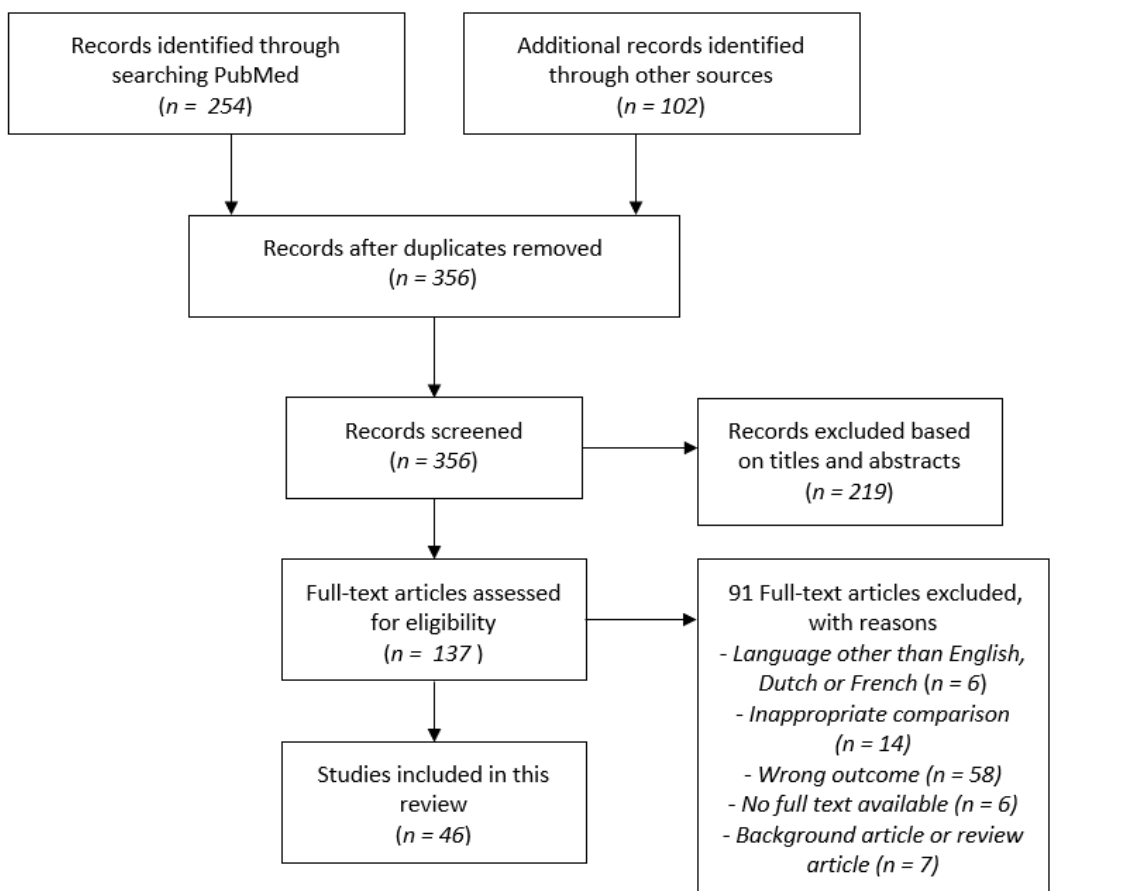
Figure 1. The literature search and selection process.